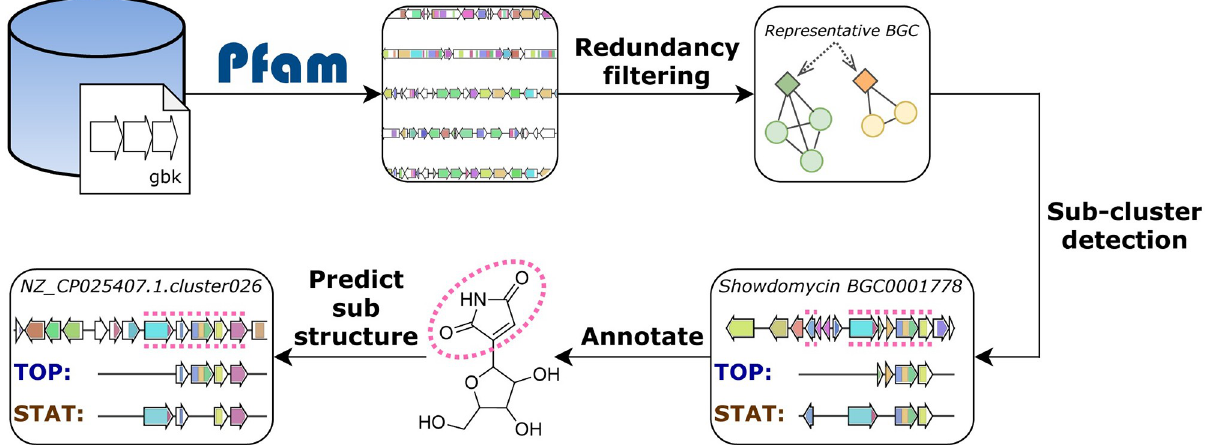
Fig 1. Outline of the iPRESTO workflow for the prediction of sub-clusters. All genes in BGCs are converted into strings of Pfam domains, after which redundant BGCs are filtered out based on an Adjacency Index of domains. Sub-clusters are predicted using two methods: PRESTO-TOP (TOP) and PRESTO-STAT (STAT). BGCs from the MIBiG database are used to annotate putative sub-clusters with sub-structures. These annotations are used to predict sub-structures in unknown BGCs.